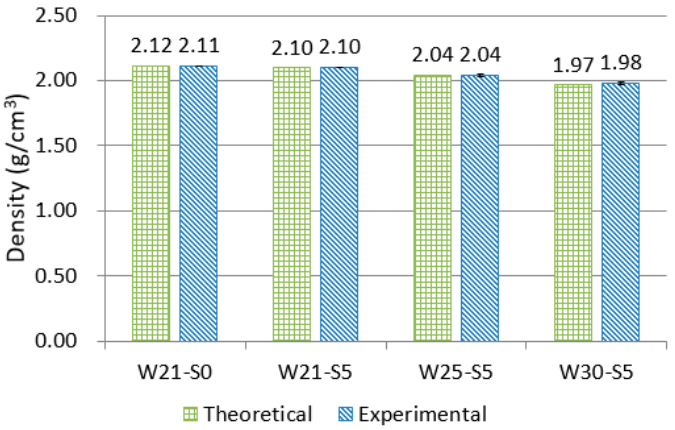
Figure 2. Theoretical and experimental density of mixtures.